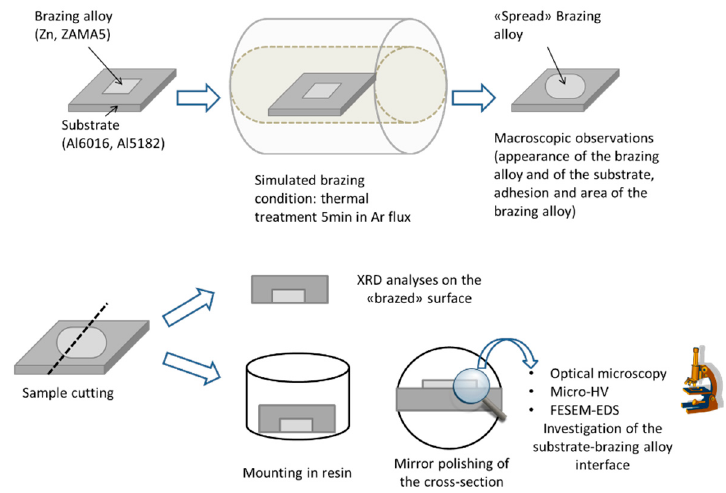
Figure 1. Scheme of the research setup and rationale.